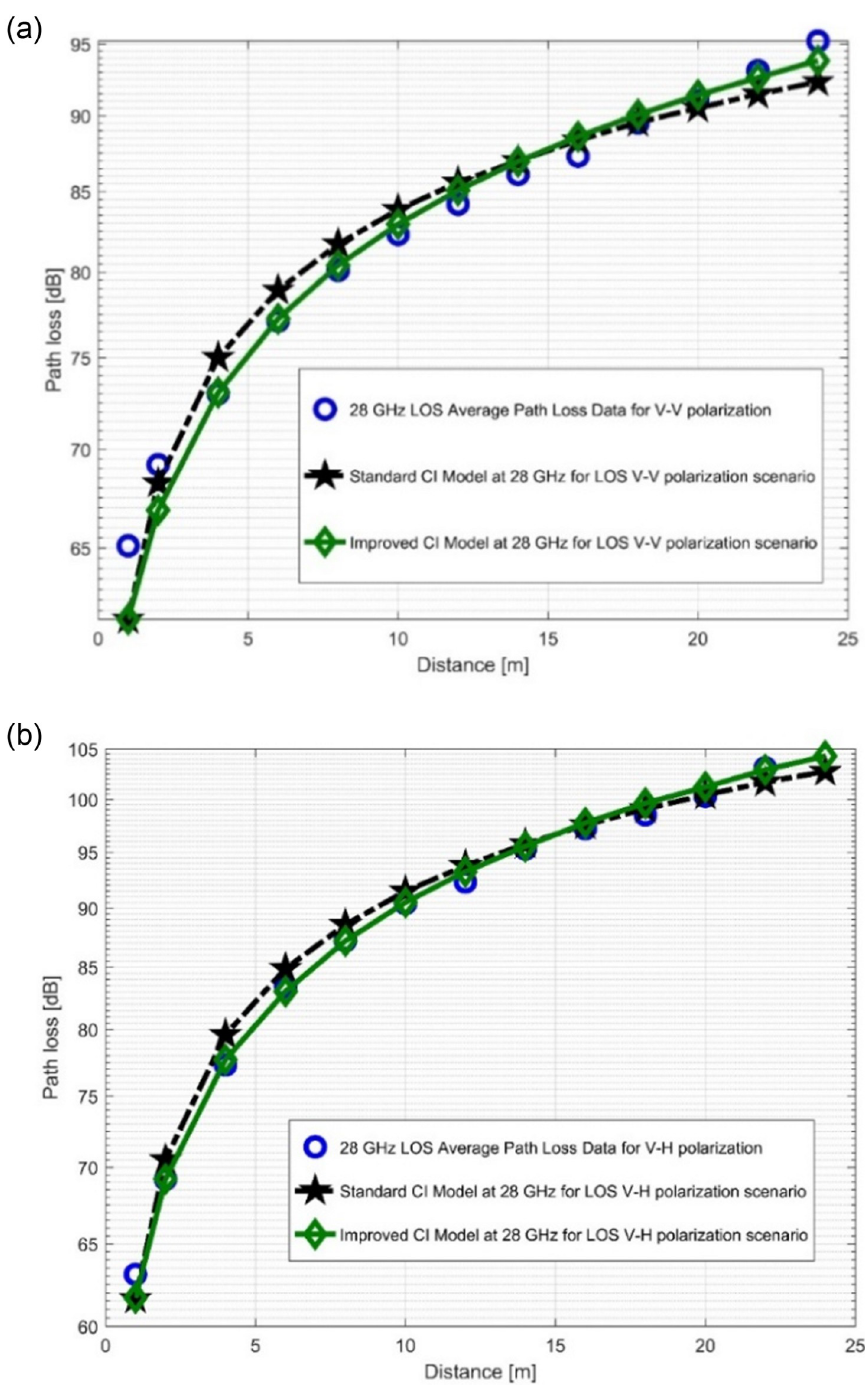
Fig 8. PL versus (vs) distance at 28 GHz for the LOS scenario at (a) V-V polarization, (b) V-H polarization.